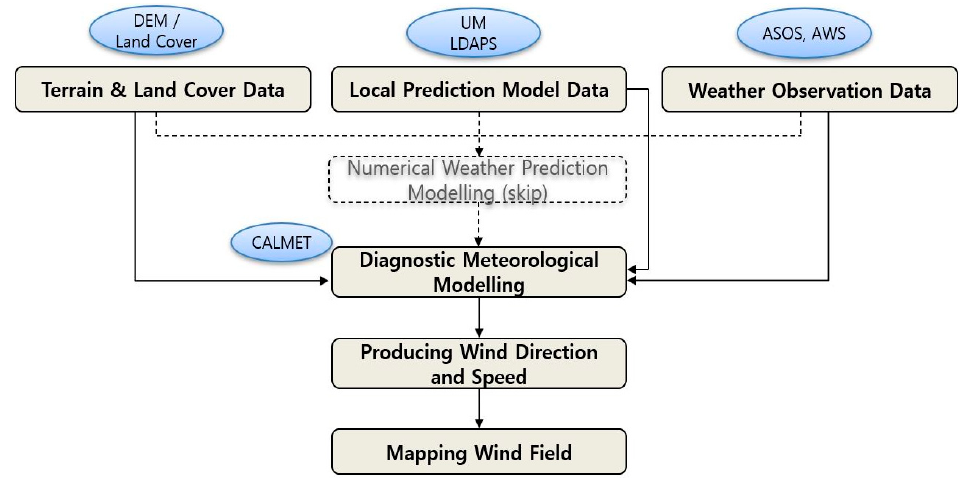
Figure 7. Wind field mapping process without numerical weather prediction modeling and with the application of a diagnostic meteorological model: DEM, digital elevation model; UM, unified model; LDAPS, local data assimilation and prediction system; ASOS, automated synoptic observation system; AWS, automatic weather station; WRF, weather research and forecasting model (one of the numerical weather prediction models employed); CALMET, California meteorological model (a type of diagnostic meteorological model).